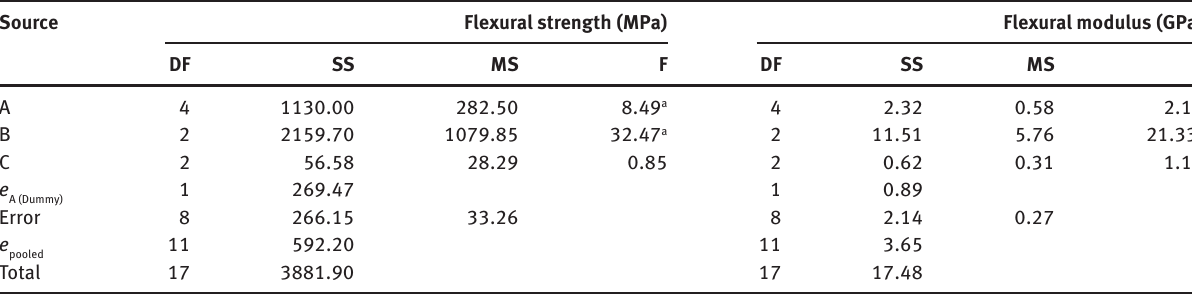
Table 5: ANOVA table for the flexural properties of composite. Source